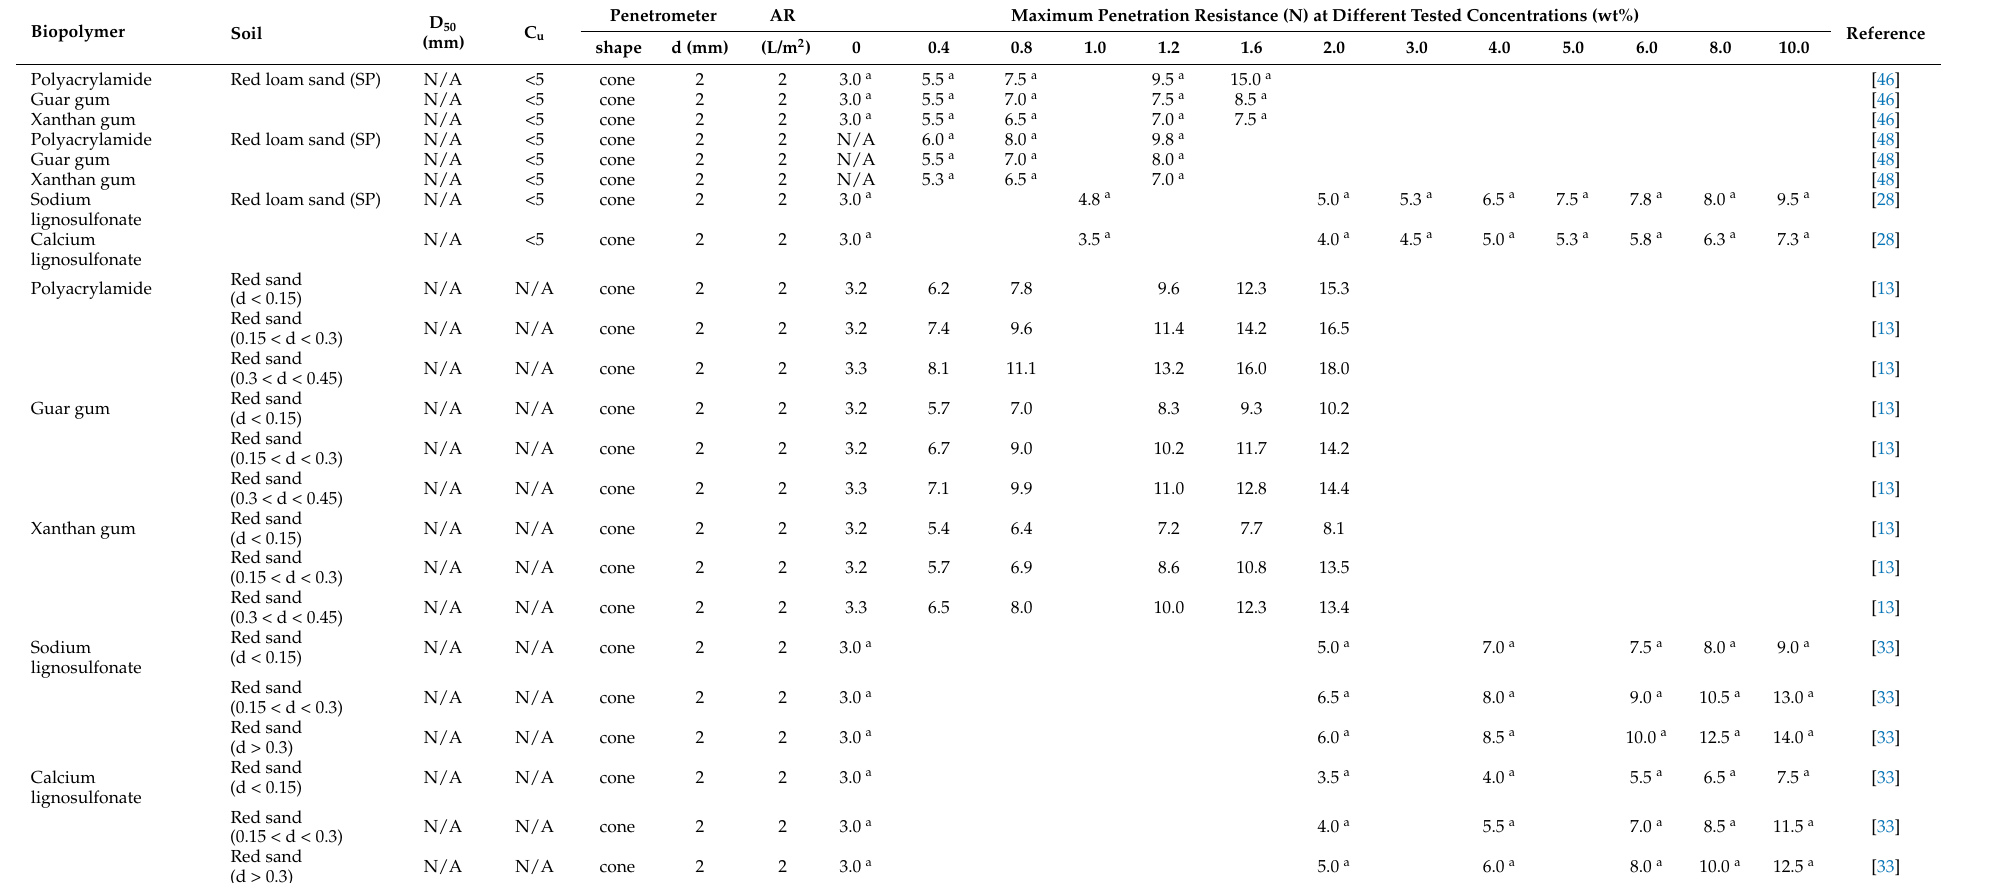
Table A8. Compilation of results from previous studies performing penetrometer testing on different types of red sand (bauxite residue) to assess the penetration resistance of spray-on biopolymer